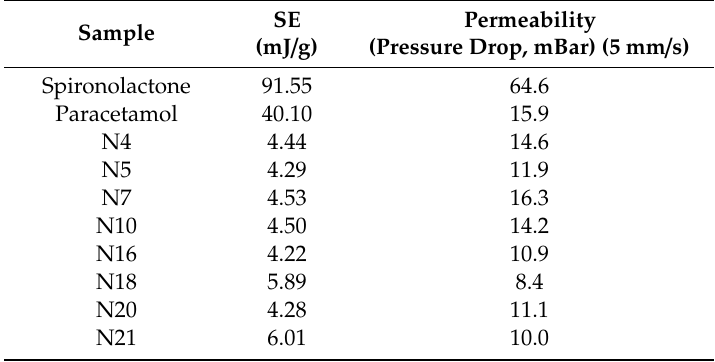
Table 2. FT4 results for pure APIs and powder blends ( n =